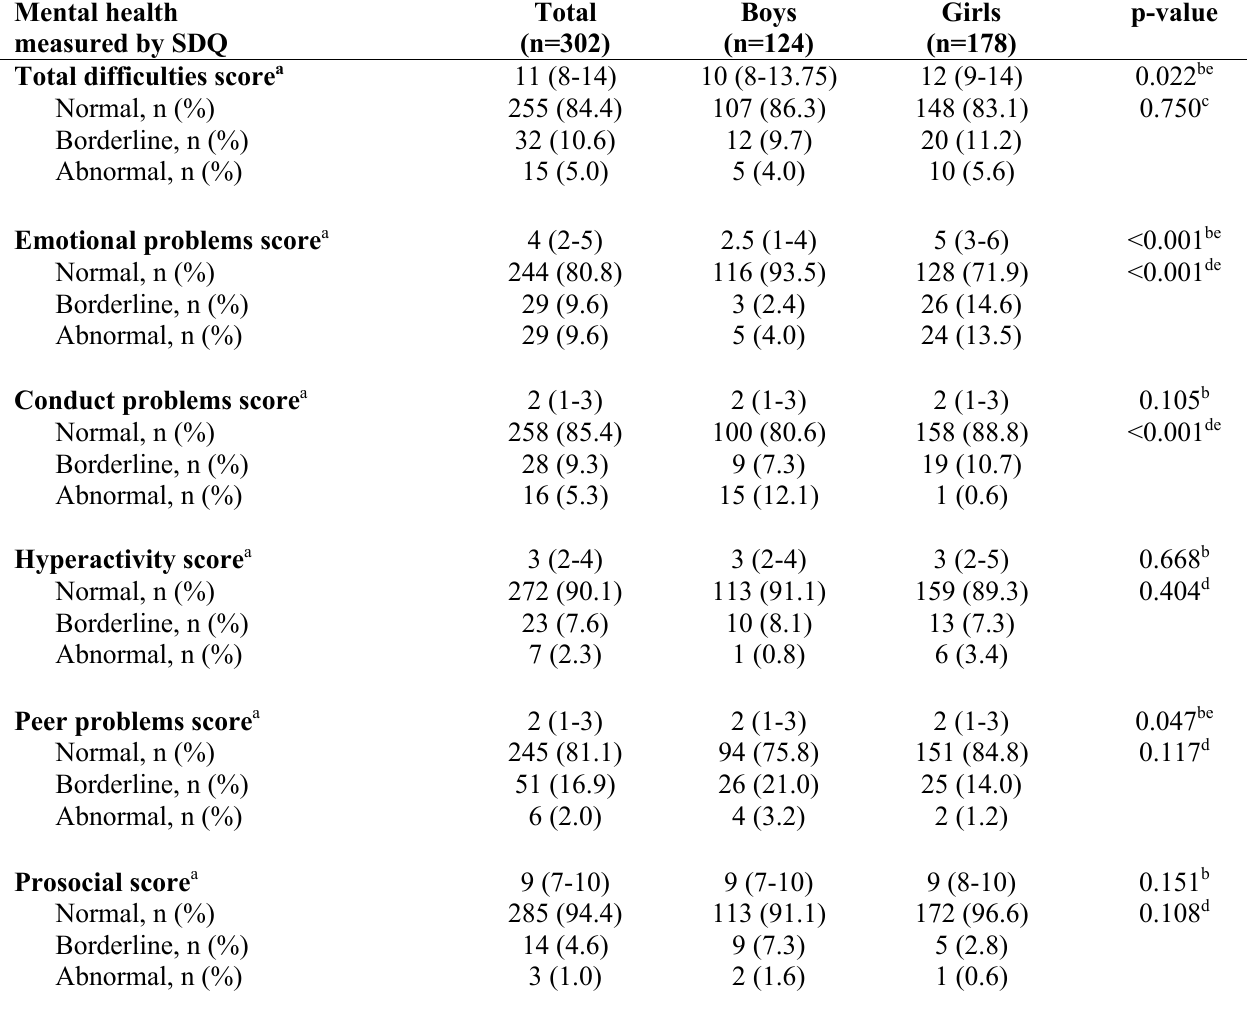
Table 4 . The subjects’ scores of total difficulties, emotional problem, conduct problem, hyperactivity, peer problem and